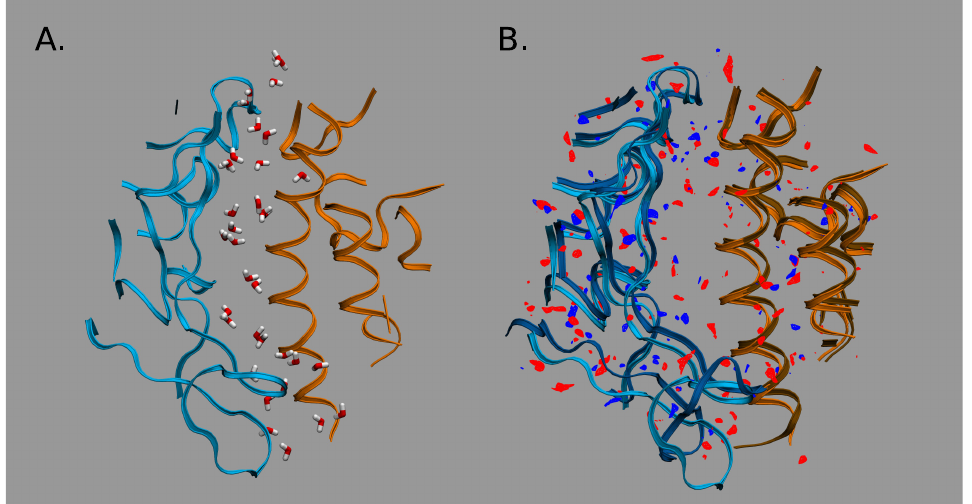
Figure 3. Water distribution in the interfacial region of complexes: ( A ) For the CoV-2-hACE2 complex. ( B ) Differences in distributions of water oxygens (blue colour) and water hydrogens (red colour) between the CoV-2-hACE2 and CoV-hACE2 complexes. The RBD is indicated by blue ribbons, the hACE2 by orange ribbons, and the CoV-hACE2 is shown as background for the